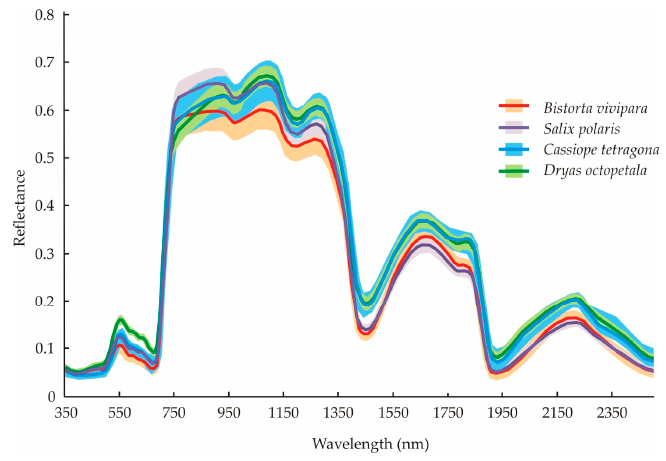
Figure 3. Average and standard deviation (strip) of spectral reflectance curves of analyzed species.